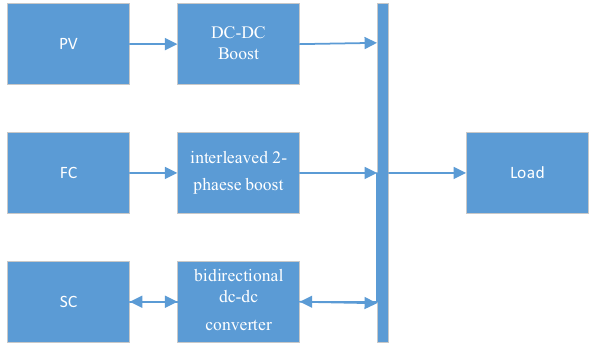
Fig. 1 The proposed hybrid system with PV and FC as primary sources, and supercapacitor as an auxiliary source connected in parallel with the load side. Where the PV is connected via a boost converter, the FC is connected by an interleaved two-phase boost converter and the SC is connected via a bidirectional DC–DC con-